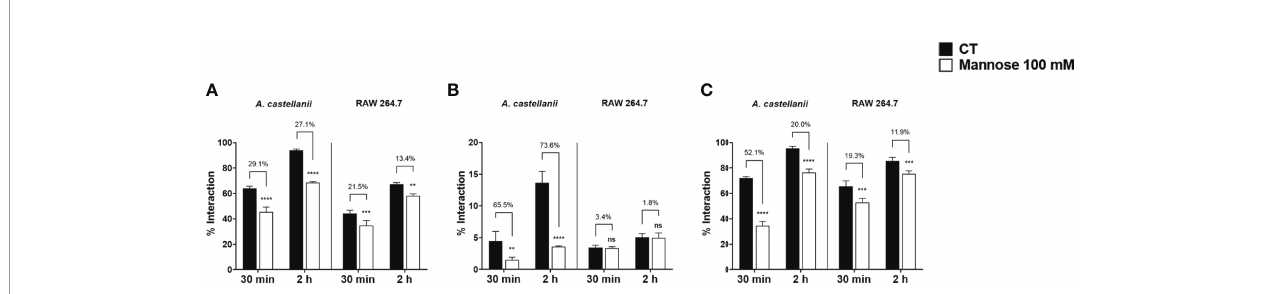
FIGURE 7 | The mannose receptor plays an important role in the events of fungal interaction with Acanthamoeba castellanii and macrophages. After NHS- Rhodamine labeling of (A) Candida albicans , (B) Cryptococcus neoformans and (C) Histoplasma capsulatum , interaction assays were performed with both A. castellanii and RAW 264.7, with phagocytes model indicated on the graphs, in two conditions: absence (Control group, black bars) and presence of 100 mM soluble mannose (Mannose 100 mM, white bars) and analyzed upon 30 min and 2 h. The interaction ratios were determined in each case, and inhibition percentages (numbers above bars) calculated as followed: (Control - Pre-treated group) x 100/Control. The statistical signi fi cances comparing inhibition x controls are displayed above each group (**p < 0.01; ***p < 0.001; ****p < 0.0001; ns, not signi fi cant). The bars represent the average of three independent experiments, performed in triplicates.